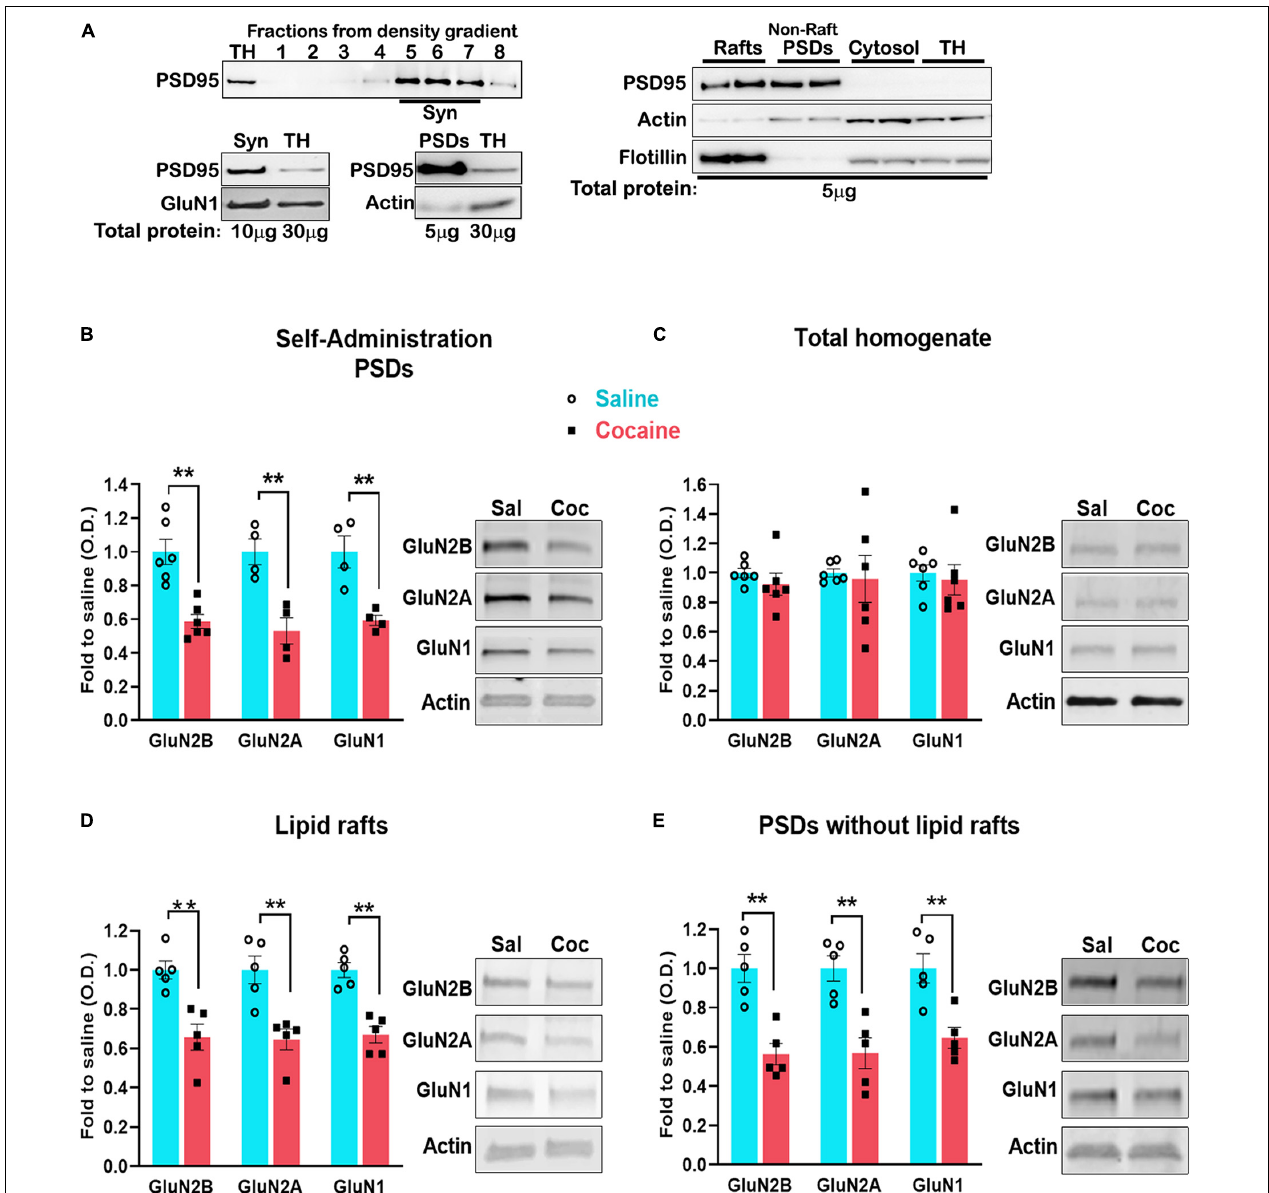
FIGURE 3 | Blots of the cellular fractions obtained by density gradient (see section “Materials and Methods” for details) (A) . Dorsal striatum was dissected 24 h after the last self-administration session. Total PSD enriched fraction (B) was isolated and analyzed by western blot to detect the indicated proteins. Lipid raft (D) and PSD without rafts (E) were isolated from the total PSD and analyzed by western blot. Total protein (C) . For lipid rafts and PSD isolation, n = 6 samples/group, 4 mice/sample, total of 24 animals/group. Data are represented as mean ± SEM (minimum of 5 independent samples). ** p <